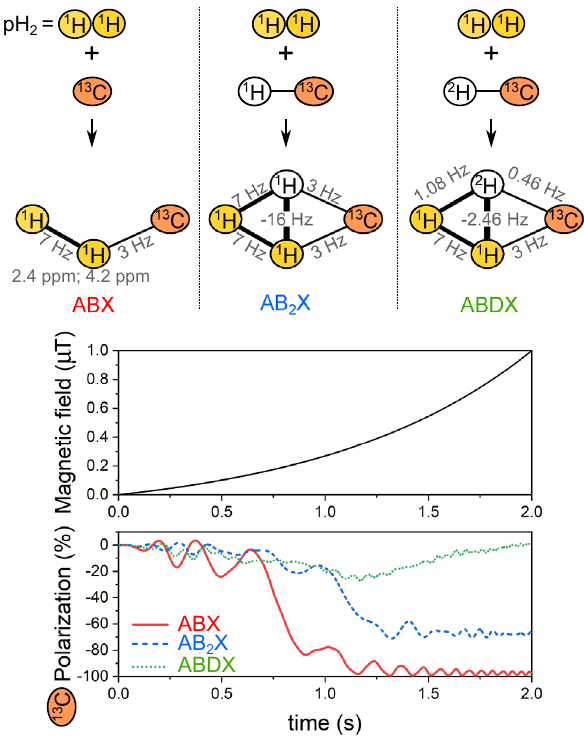
Figure 2. Simulation of spin order transfer in a magnetic field cycling experiment for three molecules with spin system topologies ABX, AB 2 X, and ABDX. The same exponential magnetic field profile ( B ) was used: M (cid:31) e k · t − 1 (cid:30) with M = 156.5177 nT and k = 1 s -1 . 13 C-Polarization of the order of 100%, 70%, and 0 is predicted for ABX, AB 2 X, and ABDX systems. J -coupling constants and chemical shifts of protons are given in the scheme. D is 2 H, A and B are 1 H coming from pH 2, and X is 13